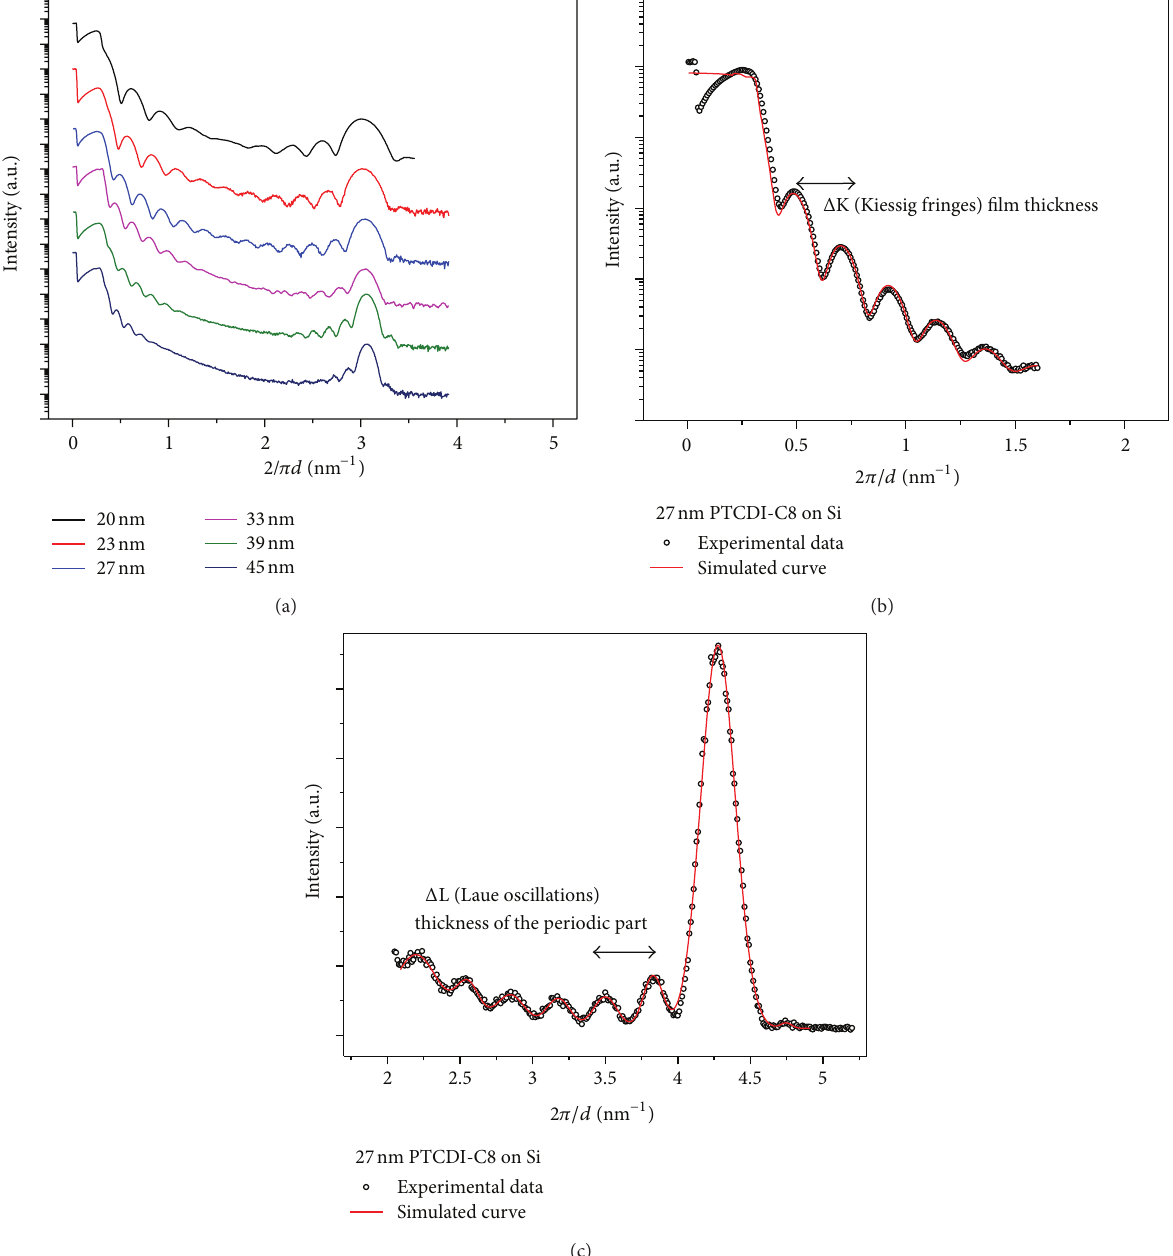
Figure 4: X-ray reflectivity curves for (a) different thicknesses of PTCDI-C8 films as well as the measured and simulated reflectivity data for (b) Kiessig fringes and (c) Laue oscillations for PTCDI-C8 film with 27 nm thickness. model, the transmitted X-ray in the top-most layer serves as a new source for the scattering at the next lower interface